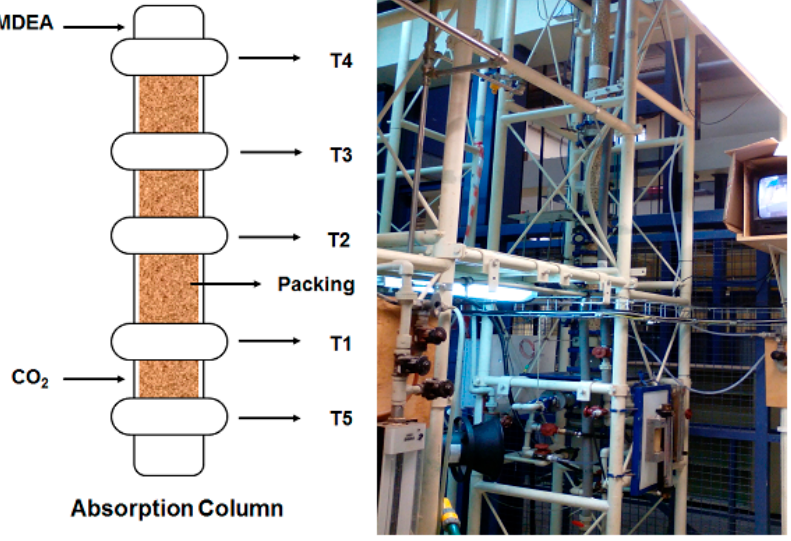
Figure 5. Large pilot unit and absorption column detail.